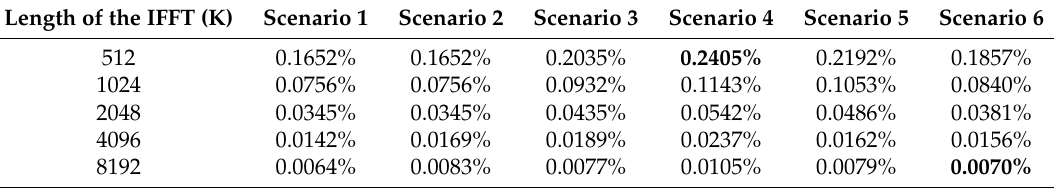
Table 2. Maximum measured error vector magnitude (EVM) ( EVM max ) for PSI algorithm.